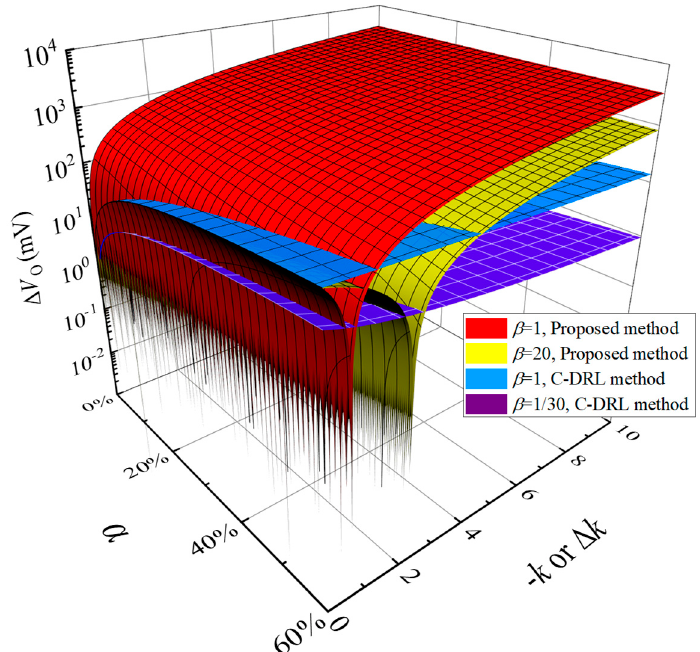
Figure 6. The performance comparison between C-DRL method and the proposed noise neutralization method, where the red and yellow surfaces represent the proposed method with β being 1 and 20, respectively. The blue and violet surfaces represent the C-DRL method with β being 1 and 1 / 30, respectively. When the impedance mismatch coe ffi cient α exists, ∆ k in a certain range of the proposed method can obtain a smaller PDMC than that of C-DRL method and there always exists